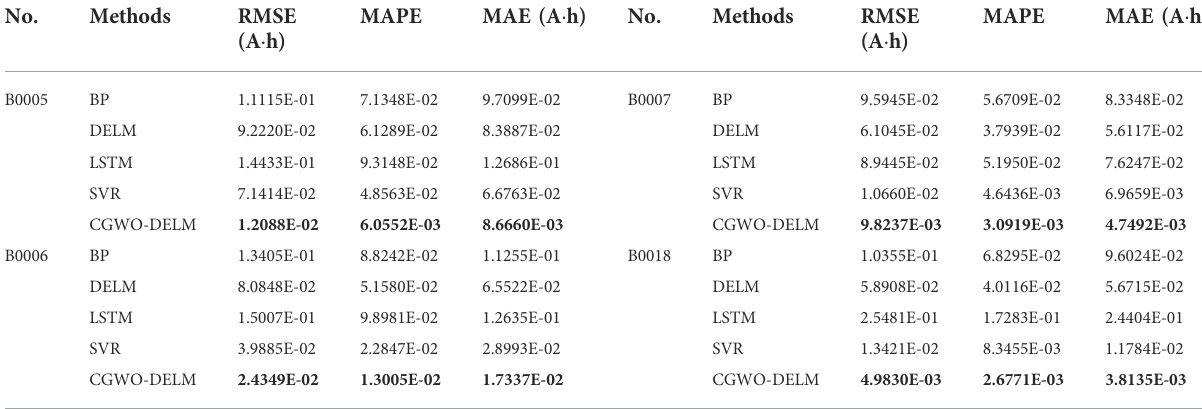
TABLE 7 Comparison of evaluation indexes (the fi rst 80 cycles of data are used as the training set).